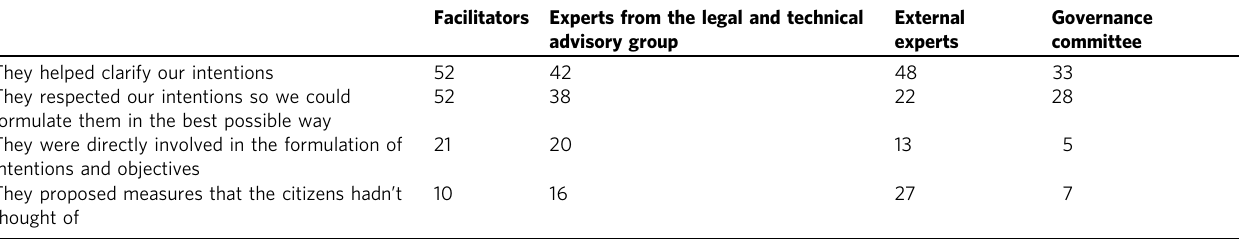
Table 5 Survey results. Citizens ’ perception of the different bodies ’ roles. Session 7, 63 respondents.